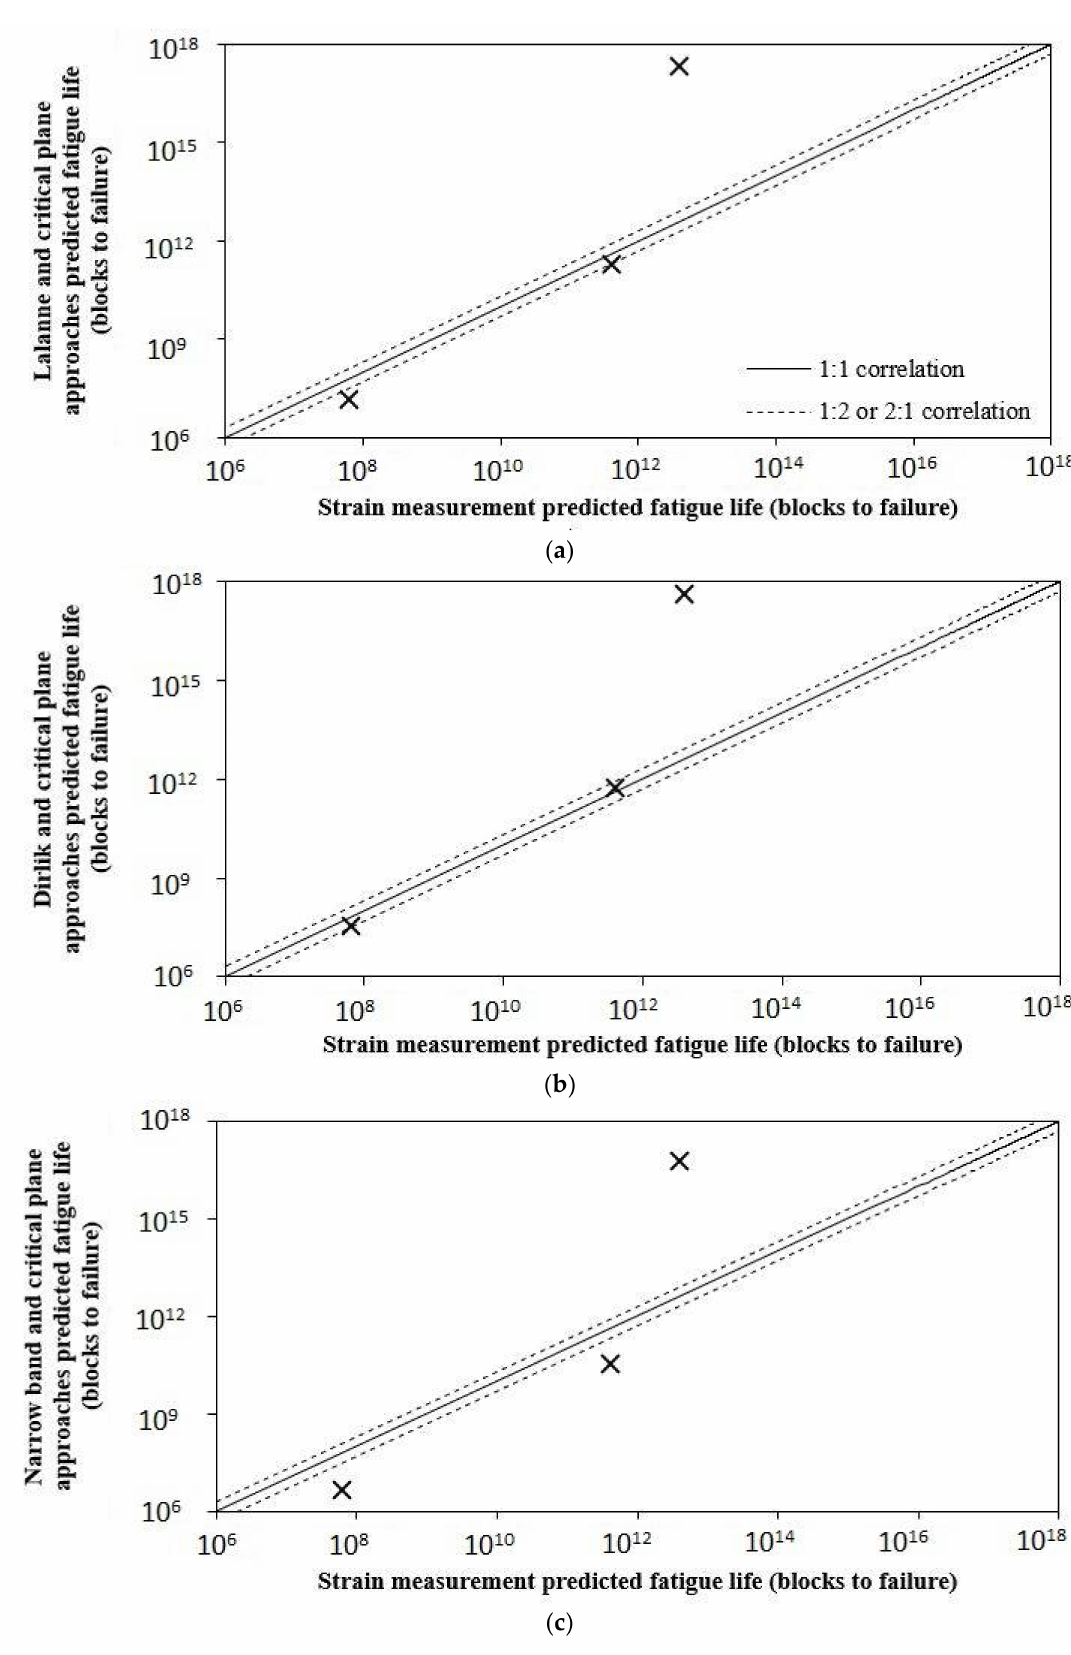
Figure 14. Fatigue life correlation curve using critical plane stress for different PSD cycle counter method: ( a ) Lalanne; ( b ) Dirlik; and, ( c ) Narrow